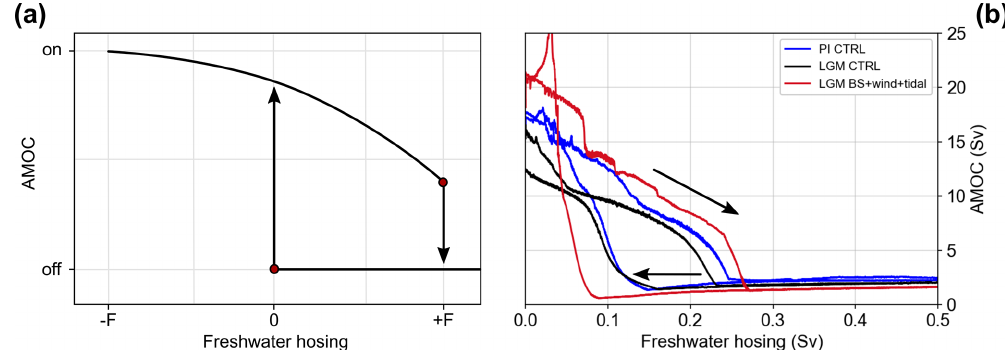
Figure 5. (a) Schematic hysteresis structure of the AMOC with bifurcation points (red circles; Stommel, 1961). (b) Hysteresis diagram for PI control (blue), LGM control (black), and most realistic LGM boundary conditions (red; LGM_BS + wind + tidal). Here, the freshwater was linearly increased up to 1.0Sv over a period of 10kyr and then decreased back to zero over